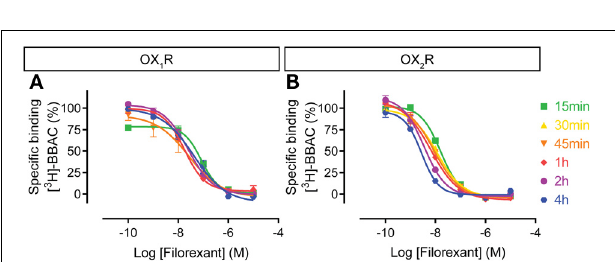
FIGURE 7 | Effect of time on filorexant competition for [ 3 H]-BBAC ((S)-N-([1,1 (cid:2) -biphenyl]-2-yl)-1-(2-((1-methyl-1H-benzo[d]imidazol-2- yl)thio)acetyl)pyrrolidine-2-carboxamide) binding to membranes from CHO cells expressing human (A) OX 1 R or (B) OX 2 R. Data is representative of triplicate determinations and error bars indicate s.e.m.